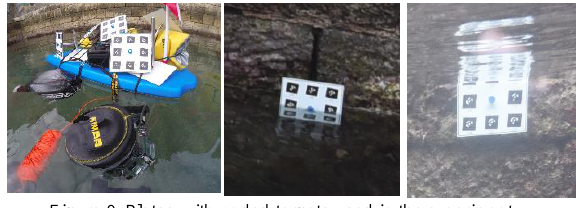
Figure 9. Plates with coded targets used in the